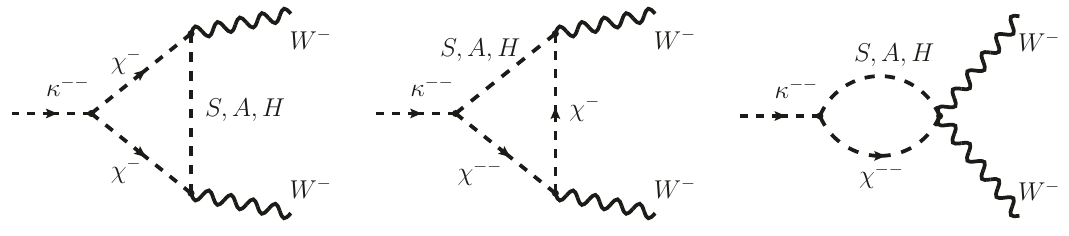
Figure 5 . One loop diagrams contributing to the (cid:20)WW vertex in the unitary